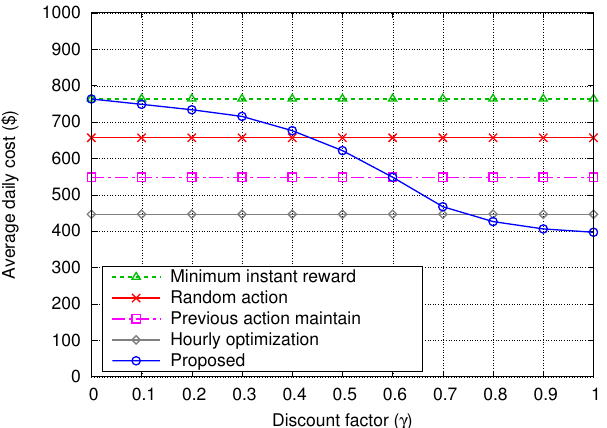
Figure 11. Average daily cost variation with respect to discount factor γ .